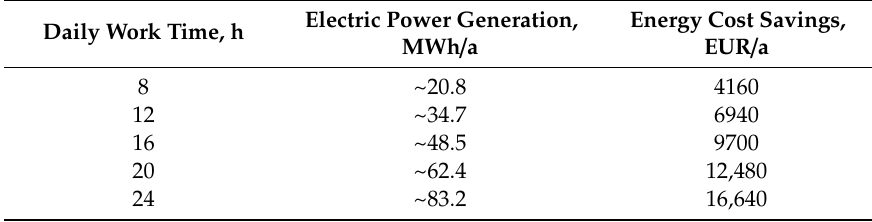
Table 3. Potential electricity generation and energy cost savings. Daily Work Time,